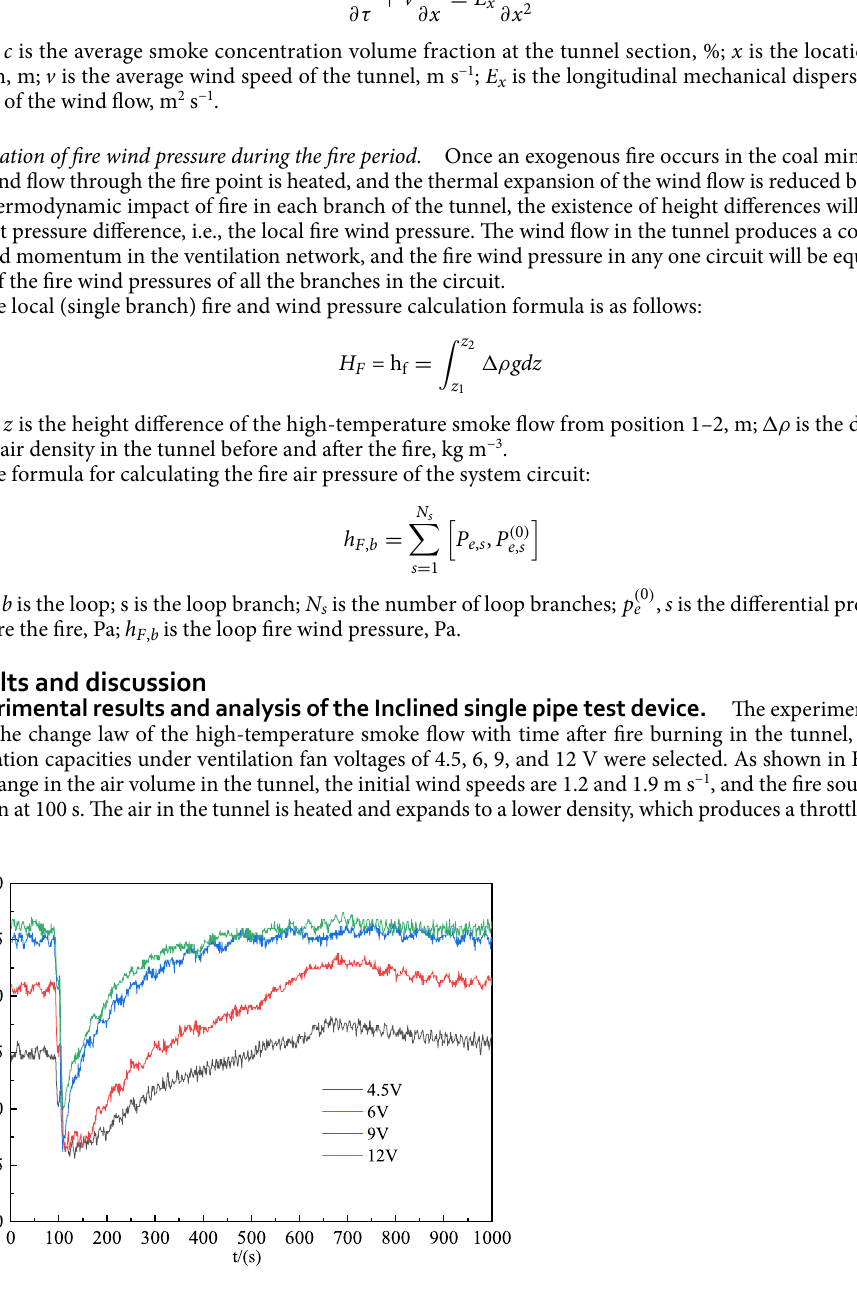
Figure 4. Variation in the wind turbulence at different air